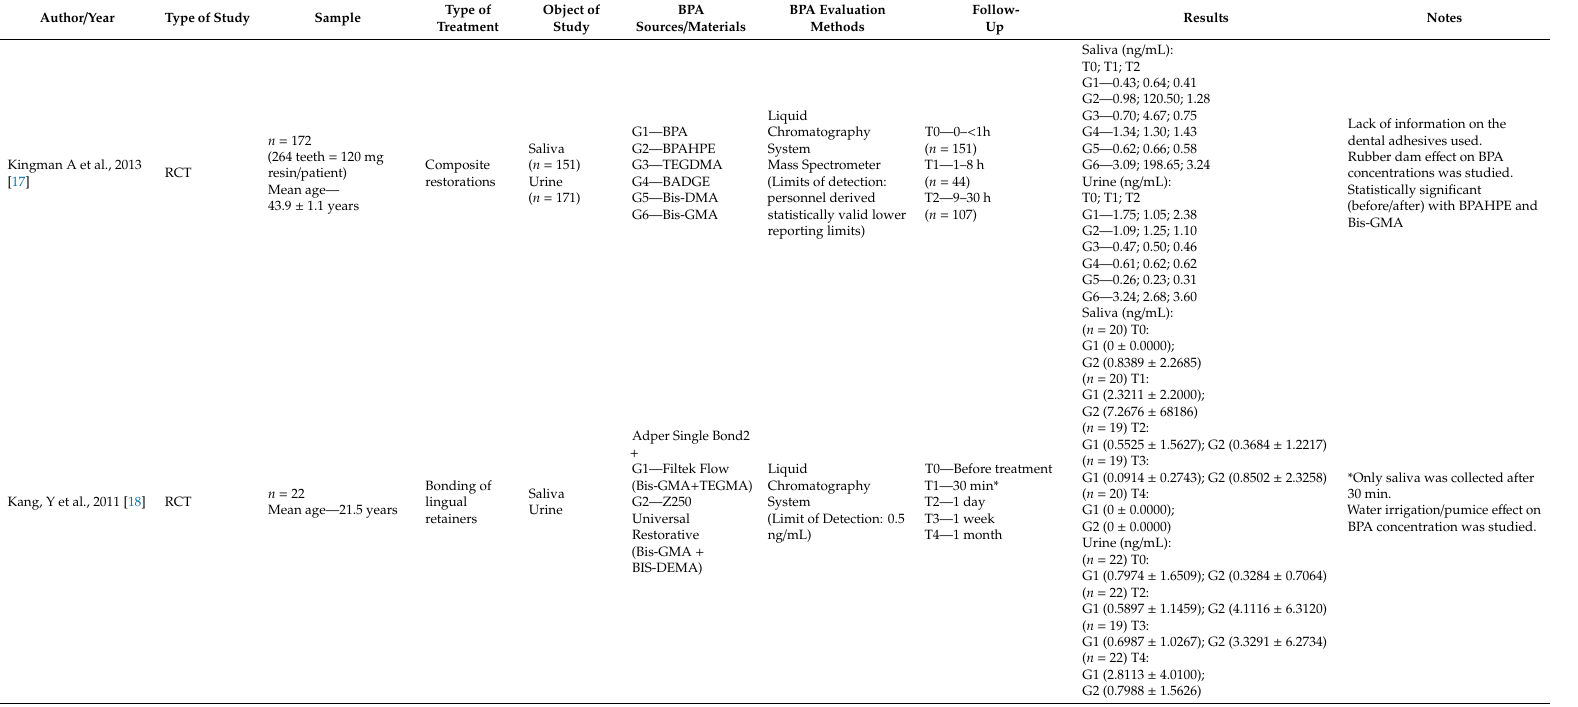
Table 1. Summary of the included studies on systematic